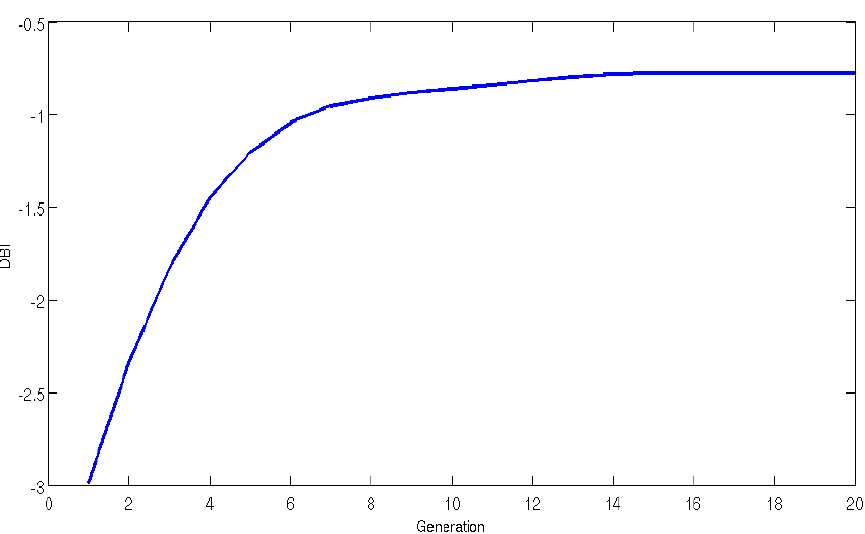
Figure 4. Generation fitness during the